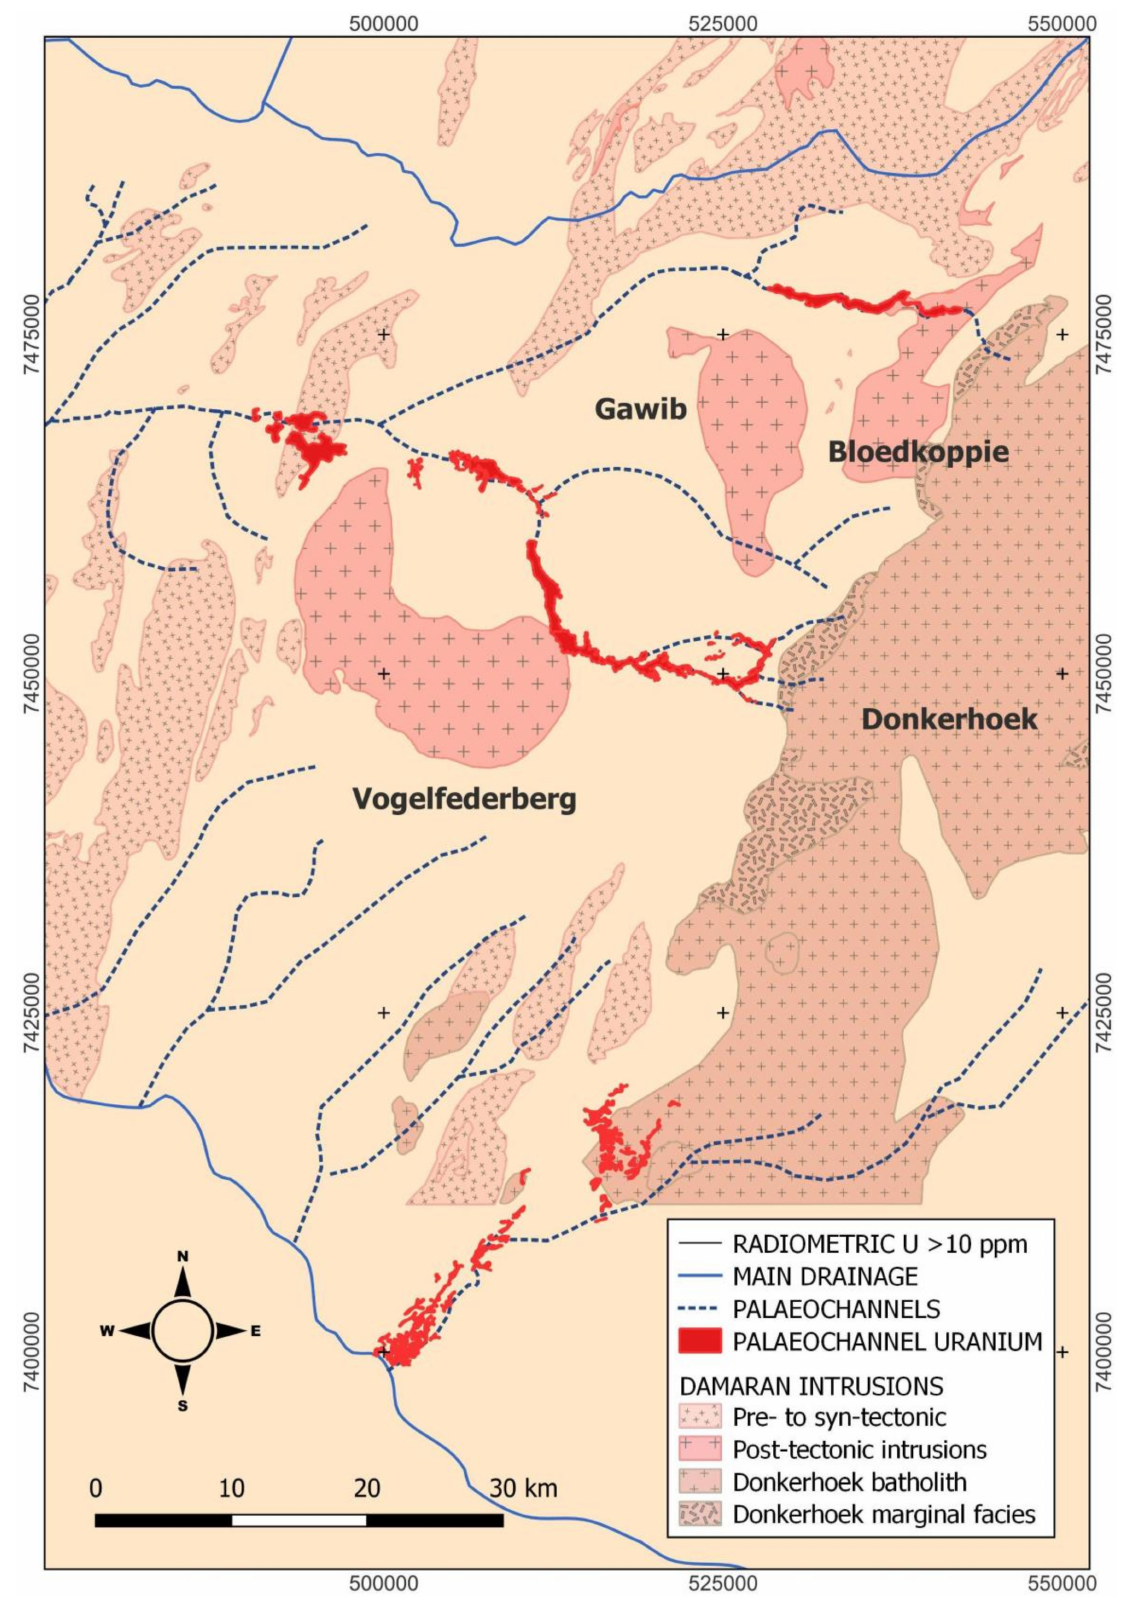
Figure 11. Simplified geological map showing the distribution of felsic intrusions north of the Kuiseb